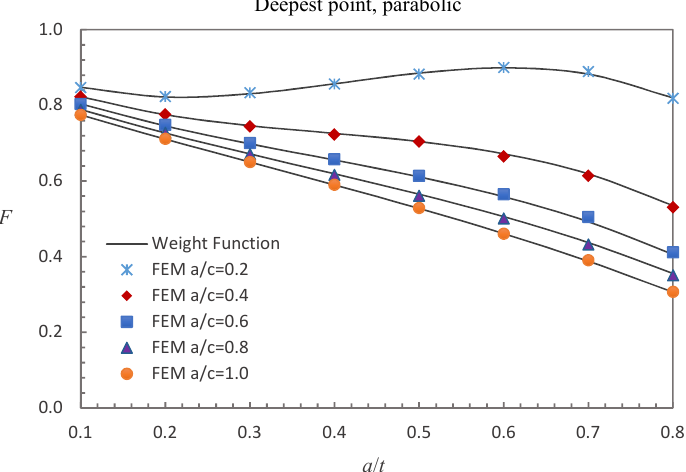
Figure 6. Comparison of weight function and FE results in this study with parabolic stress distribution (deepest point).